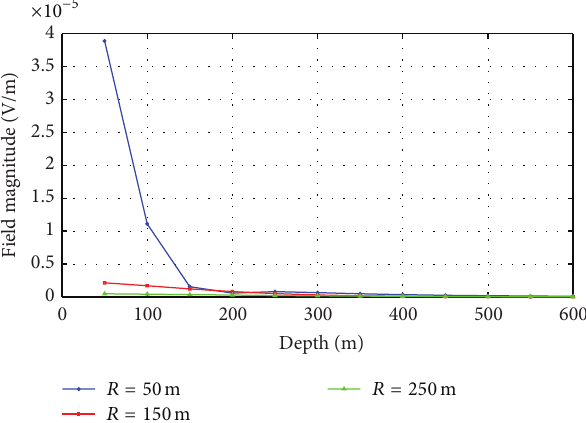
Figure 9: Curves of the radial component of the electric field magnitude with the buried depth.